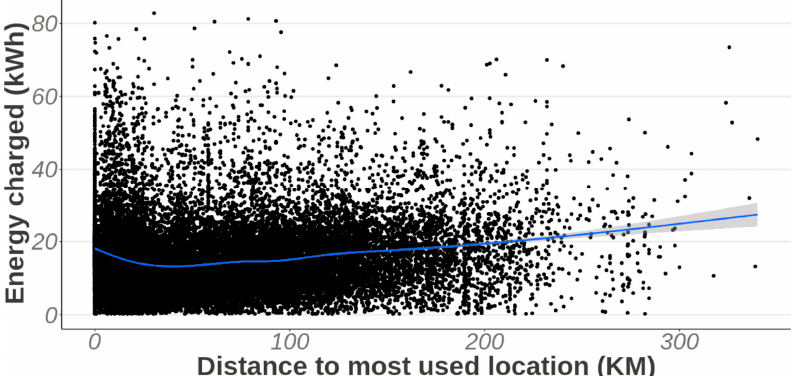
Figure 7. Scatterplot with regression line (blue) of energy charged at fast charging stations in relation to distance to most used charging location.